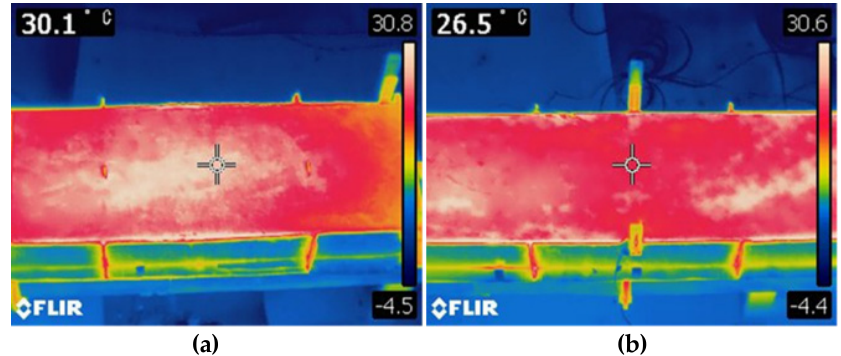
Figure 11. Concrete surface temperature distribution. ( a ) Steam curing ( b ) MW heat curing (ex: MW2).